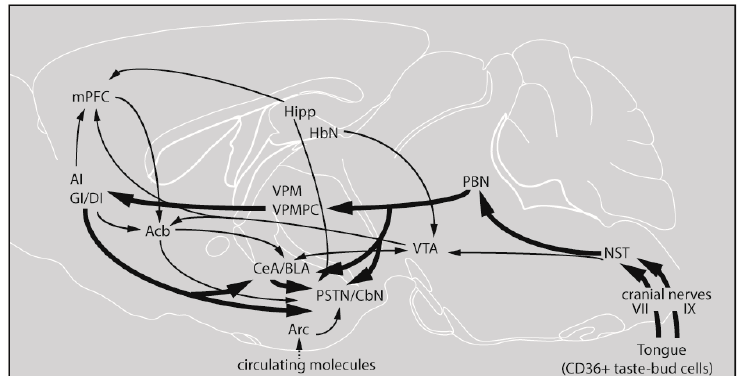
Figure 4. Schematic representation of the gustatory pathway, depicting the major central synaptic relays and their connections with structures involved in metabolic, reward and learning, and memory processes. The lingual application of a long-chain fatty acid will trigger signaling events via CD36, localized in the circumvallate papillae. The gustatory information on dietary lipids will be conveyed to the NST via cranial nerves VII and IX. The NST that serves as the relay structure of the peripheral information will send the gustatory information to different brain areas, as mentioned in the Discussion section. Acb, accumbens nucleus; AI, agranular insular cortex; Arc, arcuate nucleus; BLA, basolateral amygdaloid nucleus; CeA, central amygdaloid nucleus; GI/DI, granular/dysgranular insular cortex; Hbn, habenula; Hipp, hippocampus; mPFC, medial prefrontal cortex; NST, nucleus of the solitary tract; PBN, parabrachial nucleus; PSTN/CbN, parasubthalamic nucleus/calbindin nucleus; VPM, ventral posteromedial thalamic nucleus; VPMPC, ventroposterior medialis parvocellularis; VTA, ventral tegmental area (adapted from Reference [27]).